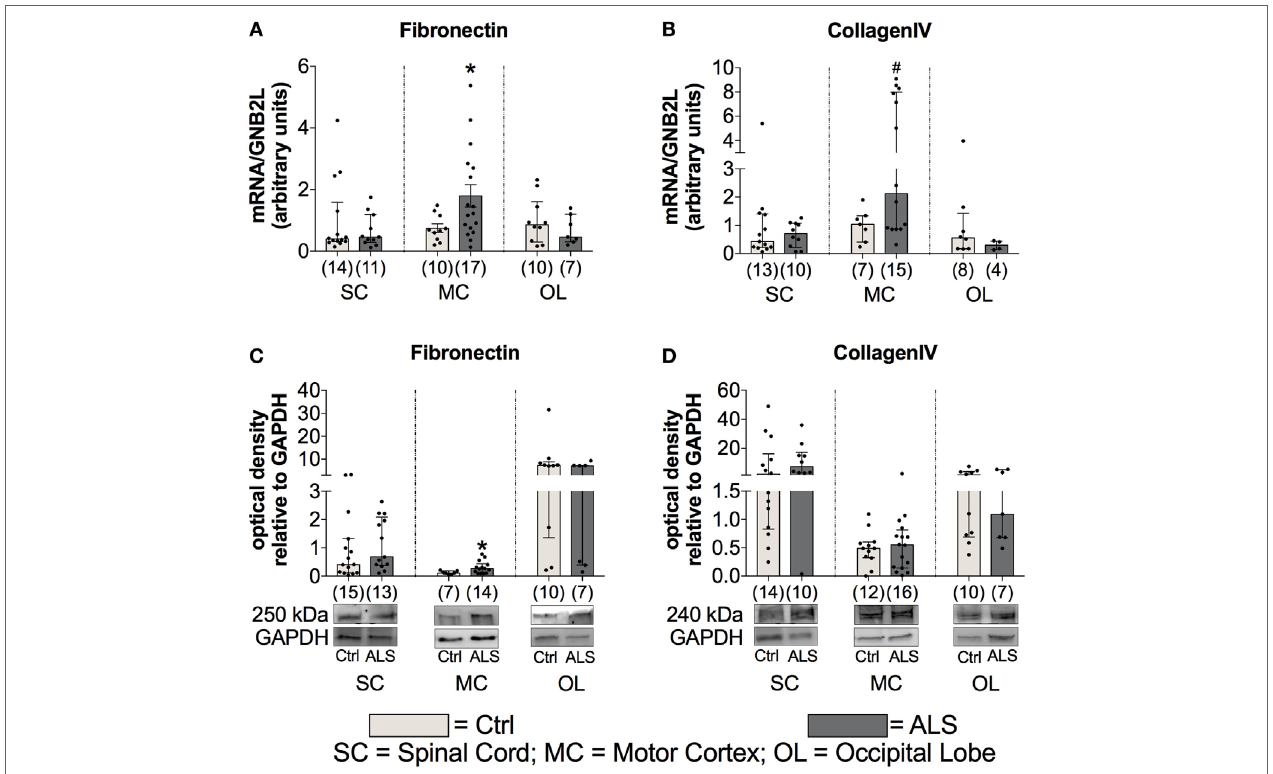
FigUre 12 | Tissue concentrations of fibrotic markers. Postmortem tissue of Amyotrophic lateral sclerosis (ALS) patients had an increased Fibronectin mRNA (a) and protein (c) expression levels in the motor cortex (MC). Further, there was a strong trend toward an enhanced CollagenIV expression in the MC of ALS patients (D) . CollagenIV mRNA levels were unchanged in all three CNS levels (b) . The amounts of both fibrotic markers were unchanged in spinal cord (SC) and the occipital lobe (OL) of ALS patients and healthy controls (Ctrl). * p < 0.05 vs. Ctrl; # = trend, p = 0.06 vs. Ctrl. Numbers of patients are given in brackets; all parameters were tested for Gaussian distribution using D’Augostino­Pearson omnibus normality test. Two­tailed Mann–Whitney test for Fibronectin mRNA (SC, OL), protein expression (SC, MC, OL), collagen IV mRNA (SC, MC, OL), and collagen IV protein expression (SC, MC, OL), data represent median with interquartile range. Two­tailed unpaired Student’s t ­test for fibronectin mRNA expression (MC), data represent mean ± SEM. Fibronectin and collagen IV protein expression levels were quantified and represented relative to the expression levels of the housekeeping protein